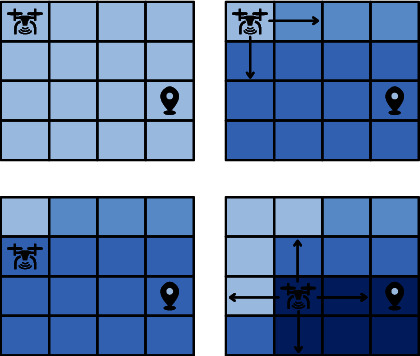
Infotaxis algorithm.